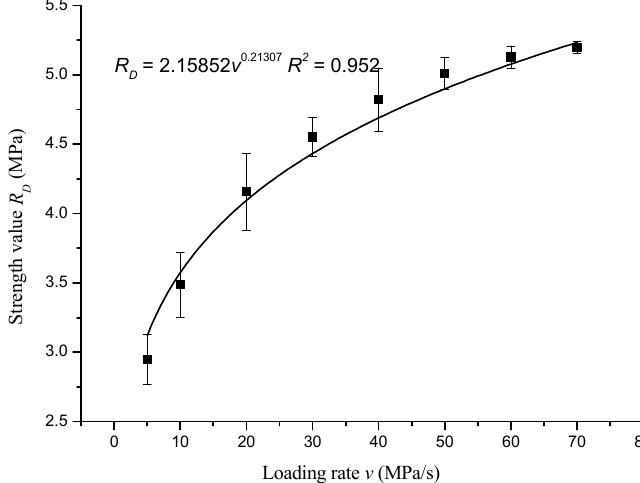
Figure 3. The curve of direct tensile strength of asphalt mixture with loading rate.